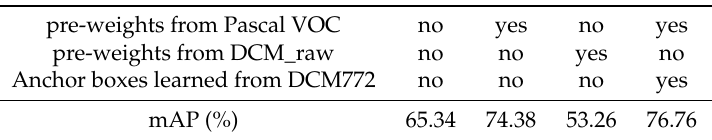
Table 6. A summary of results for character detection from panels on the DCM772 testing set. The model is trained on the DCM772 panels training set.